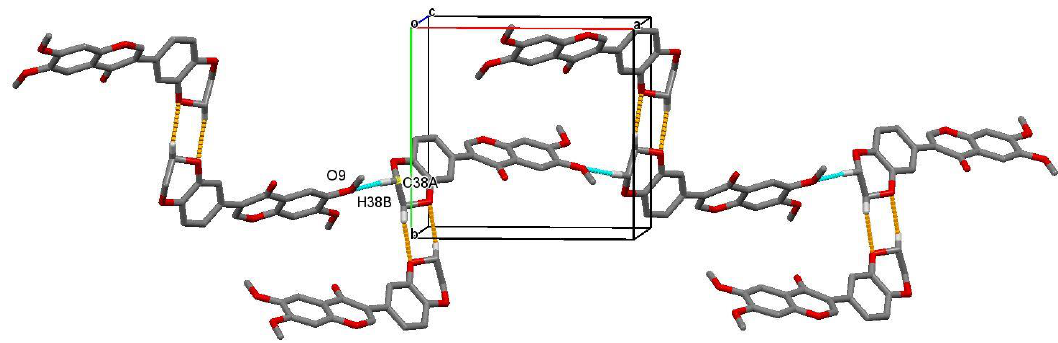
Figure 4. Pairs of hydrogen bonds form an inversion dimer (orange dashed line) which are linked into chains along the a -axis. Table 3. Intermolecular hydrogen bonds involved in the crystal packing of compound 5 (Å and ◦ ).